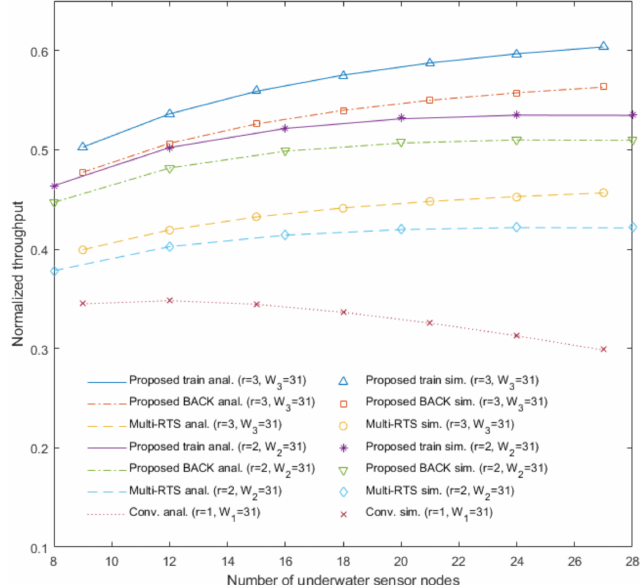
Figure 3. Normalized throughput of the proposed underwater multi-DATA train protocol, the proposed underwater BACK protocol, and the underwater multi-RTS reception protocol with r = 2 and r = 3, and the conventional CSMA / CA protocol with r =